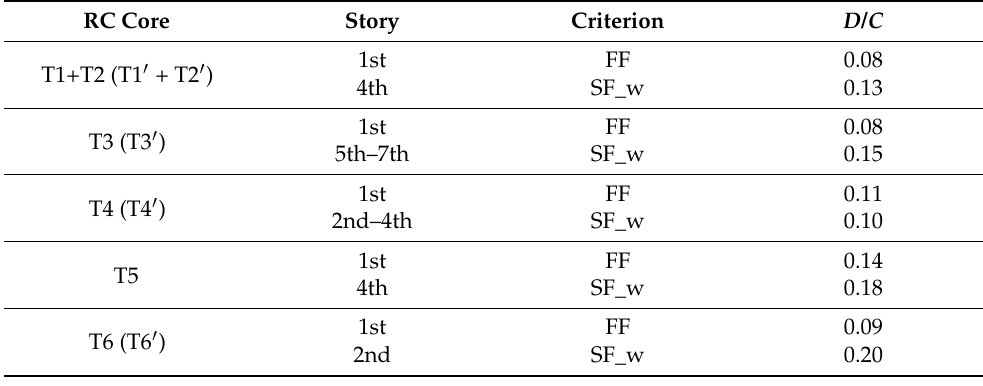
Table 8. Main numerical results of RC cores under vertical actions.